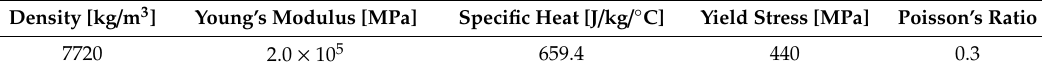
Table 2. Mechanical properties of HT50